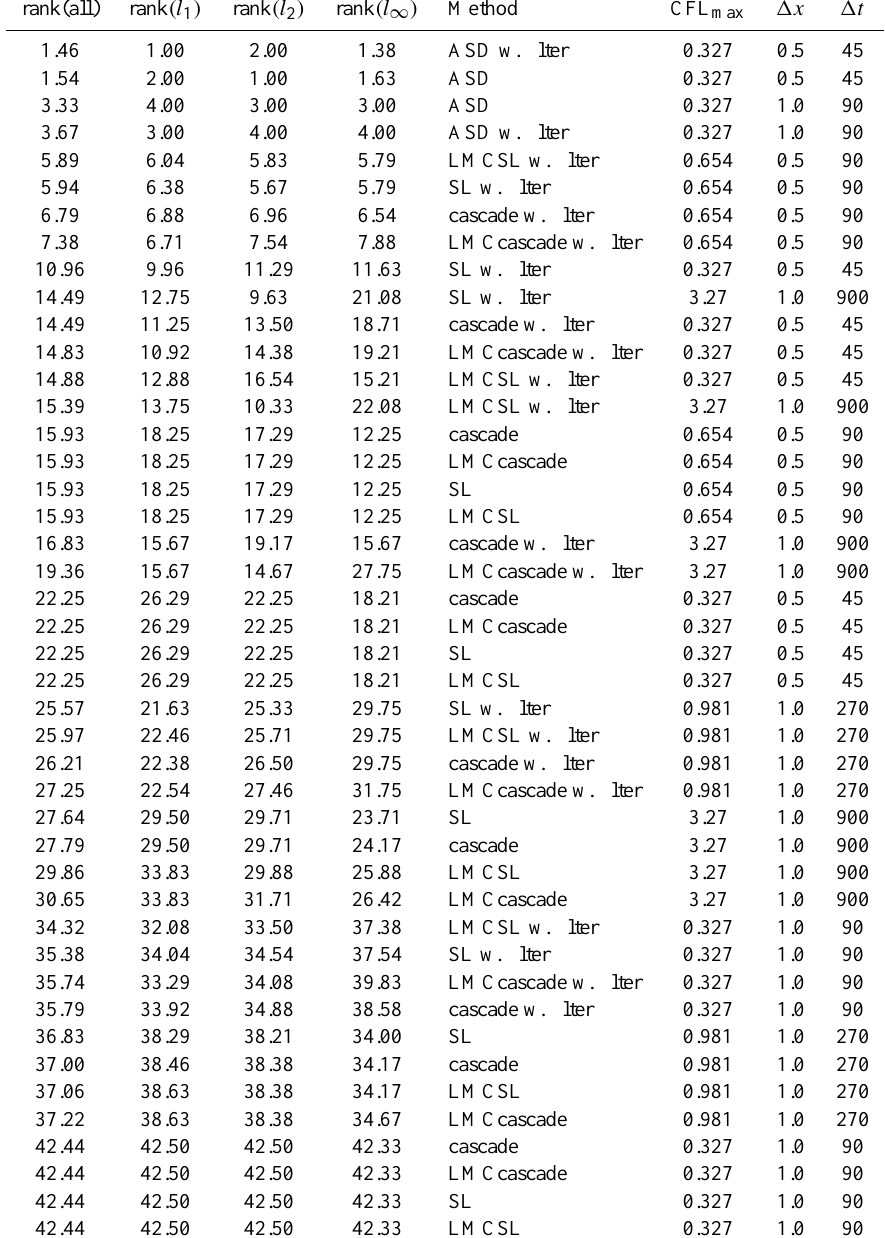
Table 5. Ranking results for the rotating cone with pure advection. Showing rank of the ranked error measures, rank of error measure l 1 , l 2 , and l ∞ followed by method, maximum Courant number, grid resolution, and time